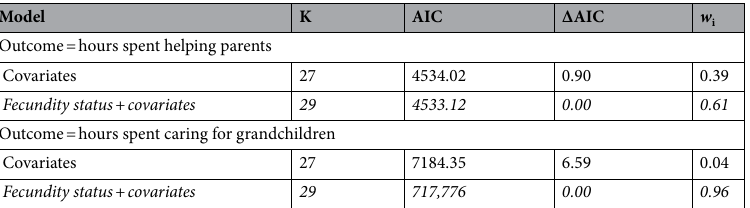
Table 1. Results from model fitting based on Akaike Information Criterion (AIC). The lowest AIC value is deemed to best fit the data, with ΔAIC referring to the difference in AIC value from the best fitting model (shown in italics). A ΔAIC value of more than two demonstrates a significantly poorer model fit, and w i indicates model probability. Covariates include number of grandchildren, age the woman left education,